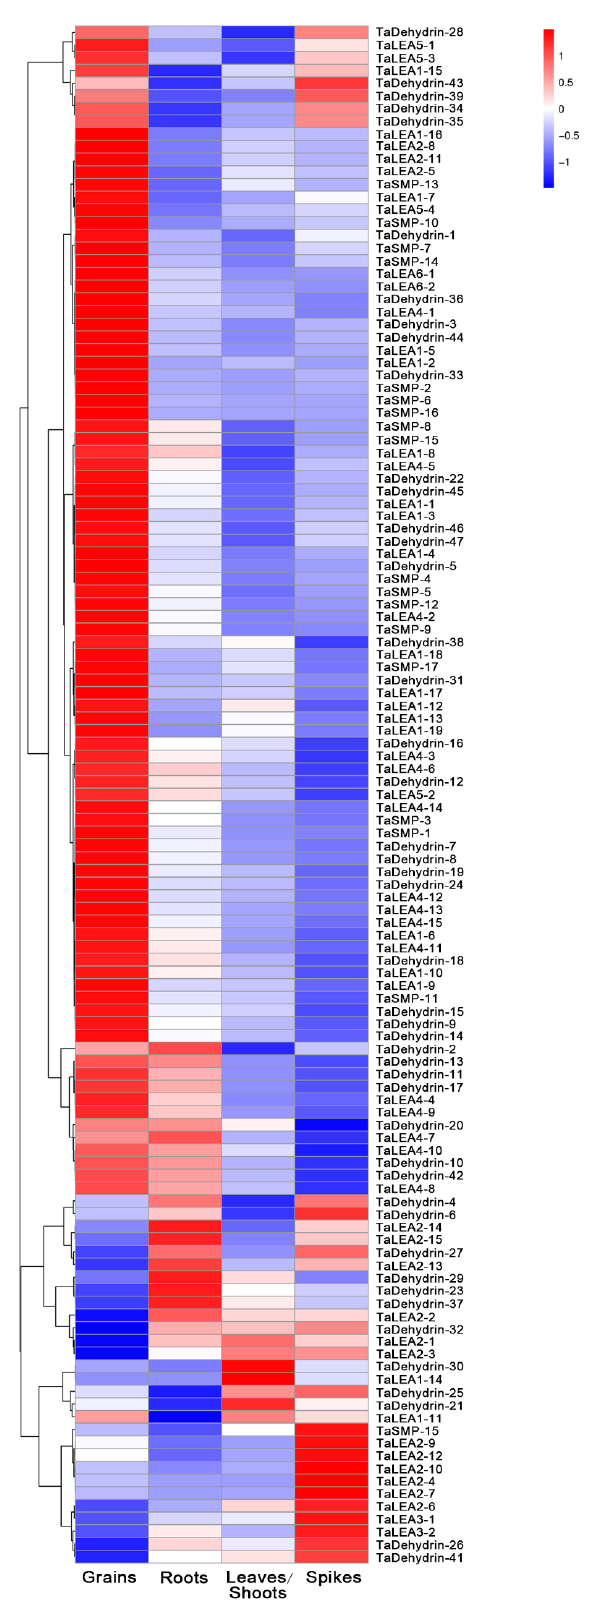
Figure 5. Expression profiling of TaLEA genes in different tissues. RNA-seq date downloaded from Wheat Expression Browser was used to analysis expression pattern. The heat map was drawn in Log 10 (tpm + 0.0001)-transformed expression values. Color scale on the right represent relative expression levels: red represents high level and blue represent low level.